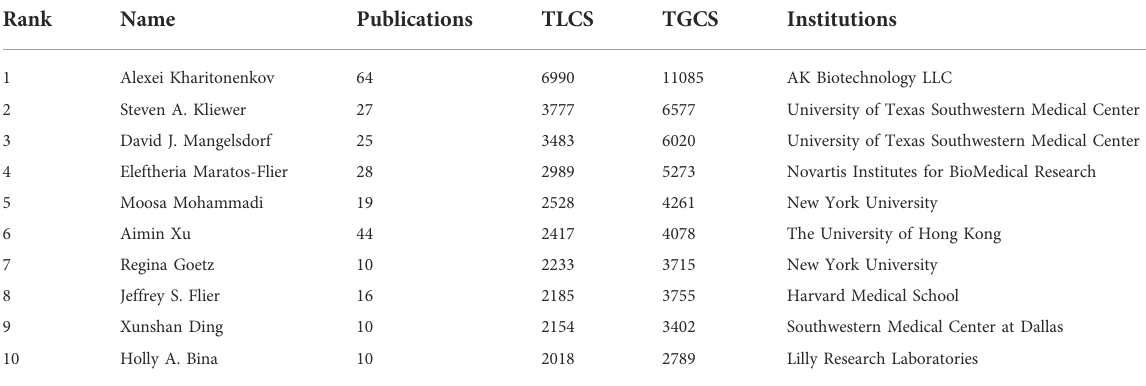
TABLE 3 Top ten authors with the highest TLCS.